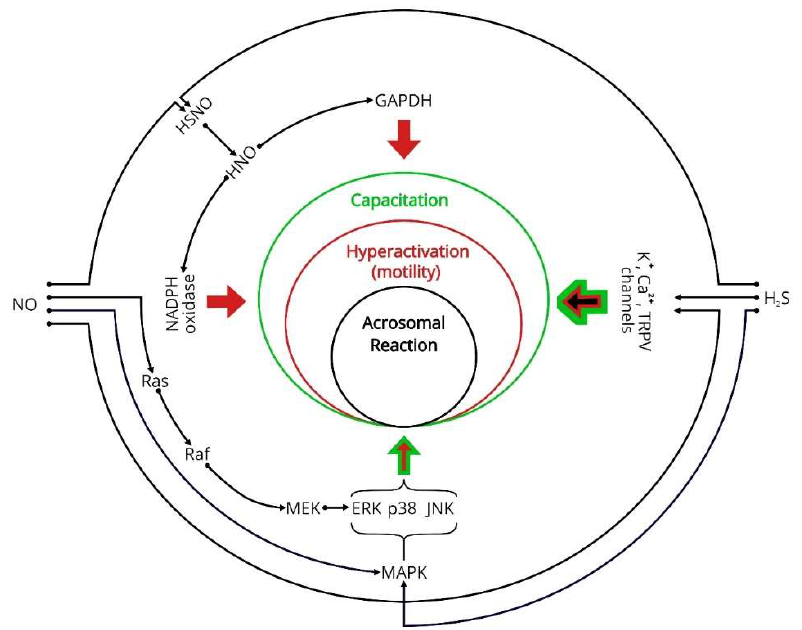
Figure 1. Common targets of nitric oxide (NO) and hydrogen sulfide (H 2 S). The scheme displays the cohesion of H 2 S and NO common targets within a cell, focusing on the most sperm-relevant enzymes and proteins. The function of NADPH oxidase and GAPDH directly affects sperm motility, as the latter requires ATP production. The sperm ion channels affect not only sperm function (capacitation, hyperactivation, acrosomal reaction), but also the outcome of the fertilization process. The MAPK complex influences the capacitation and hyperactivation of sperm cells. Colors of arrows indicate the relation with sperm biological process marked by the corresponding color. ERK, extracellular signal-regulated kinase; GAPDH, 3-phosphate dehydrogenase; HNO, nitroxyl; HSNO, thionitrous acid; H 2 S, hydrogen sulfide; JNK, C-Jun N-terminal kinase; MAPK, mitogen-activated protein kinases; MEK, MAPK/ERK kinase; NADPH, nicotinamide adenine dinucleotide phosphate; NO, nitric oxide; Raf, rapidly accelerated fibrosarcoma kinase; TRPV, transient receptor potential vanilloid.